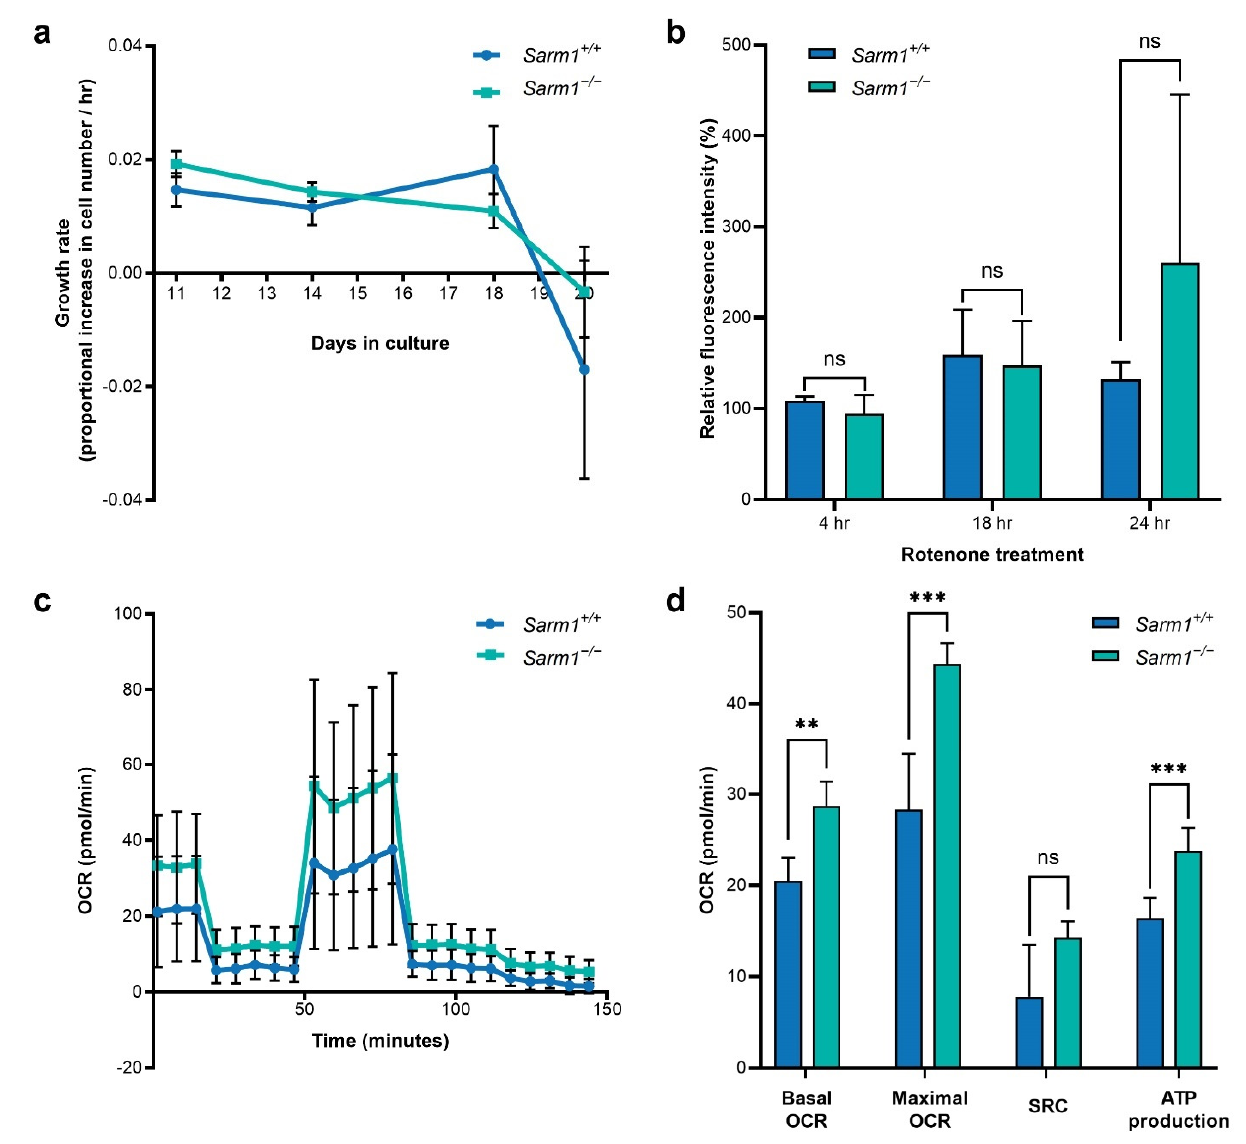
Figure 5. Growth and bioenergetics of Sarm1 +/+ and Sarm1 − / − primary fibroblasts. ( a ) Growth rate over time. Mean growth rate (proportional increase in cell population over time) for each genotype is plotted against days in culture. Sarm1 +/+ ( n = 5) shown in blue, Sarm1 − / − ( n = 5) shown in green. Growth rates were similar in both genotypes, with populations beginning to contract after 18 days in culture. ( b ) ROS accumulation following rotenone treatment. Sarm1 +/+ ( n = 4) and Sarm1 − / − fibroblasts ( n = 5) were treated with 2.5 µ M rotenone for 4, 18 and 24 h before ROS accumulation was assayed through DCFDA assay. ROS accumulated to a similar degree in both genotypes (4 h: Sarm1 +/+ 109.11 ± 4.02% fluorescence relative to control vs. Sarm1 − / − 94.92 ± 19.94%; 18 h: Sarm1 +/+ 159.09 ± 49.40% vs. Sarm1 − / − 147.35 ± 48.79%; 24 h: Sarm1 +/+ 132.62 ± 18.67% vs. Sarm1 − / − 260.50 ± 185.11%). ( c , d ) Real time measurements of OCR were taken using the Seahorse XFe96 Analyser. Oligomycin (1.0 µM), FCCP (1.0 µM), rotenone (0.5 µM) and antimycin A (0.5 µM) were injected sequentially. Basal and maximal OCR, and ATP production were increased in Sarm1 − / − fibroblasts relative to wild type (44.38 ± 2.26 pmol/min vs. 28.31 ± 6.10 pmol/min, p < 0.001; 14.28 ± 1.78 pmol/min vs. 7.80 ± 5.67 pmol/min, p < 0.05; 23.73 ± 2.57 pmol/min vs. 16.38 ± 2.62 pmol/min, p < 0.001); while SRC demonstrated a non-significant trend towards an increase in Sarm1 − / − fibroblasts relative to wild type. Error bars represent SD values, ** p < 0.01, *** p < 0.001, ns = non-significant.